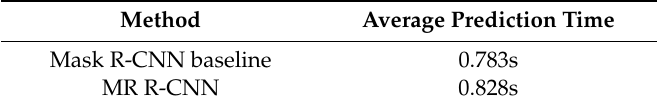
Figure 5. Comparison on the Cityscapes dataset between MR R-CNN and state-of-the-art methods. Our method is compared with the Mask R-CNN baseline in Table 4. Although the mask head becomes heavier, the computational cost is not increased substantially. The testing results on an NVIDIA 1080 Ti demonstrate that the average prediction time for a single image is increased by approximately 45 ms. Table 4. Average prediction time between the Mask R-CNN baseline and our network.